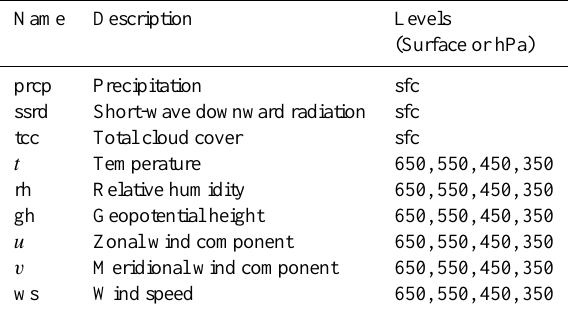
Table 1. Selected predictors from the monthly ERA-Interim